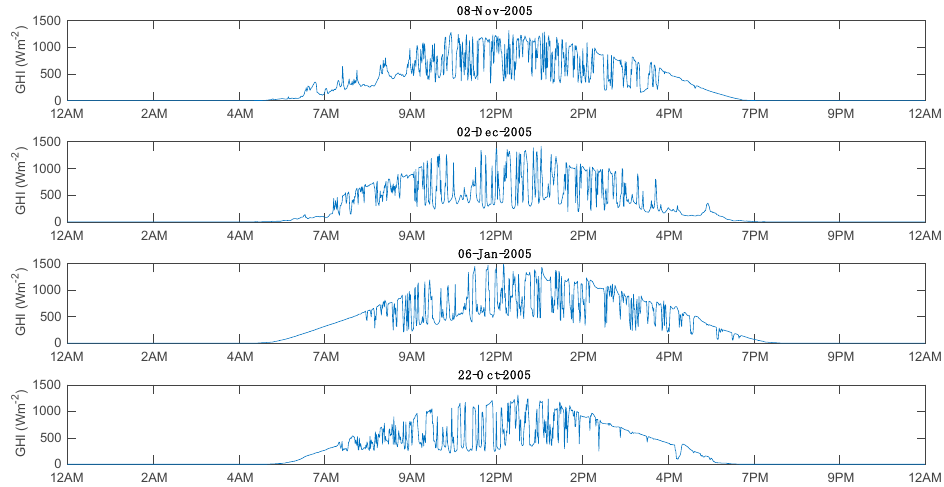
Figure 1. Highly intermittent cloudy test days as described in Table 1. The intermittent cases include days on 8 November 2005, 2 December 2005, 6 January 2005, and 22 October 2005 arranged from top to bottom.